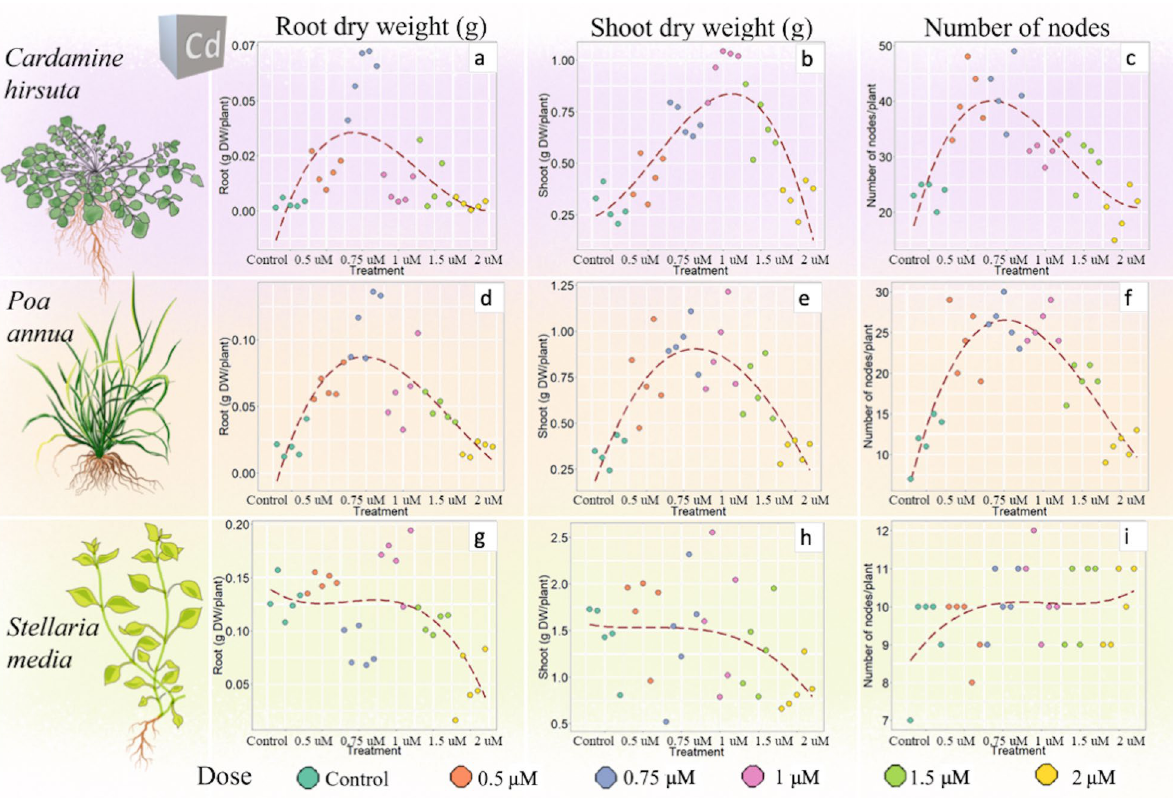
Figure 3. Effect of cadmium on root and shoot dry biomass (g DW/plant) and number of nodes per plant in Cardamine hirsuta ( a – c ) Poa annua ( d – f ) and Stellaria media ( g – i ) . A polynomial regression (dashed line) was applied to visualize the presence/absence of a hormetic curve. Each treatment is represented by 5 biological replicates (n = 5) (Supplementary Table 1). Drawings of plants by G.